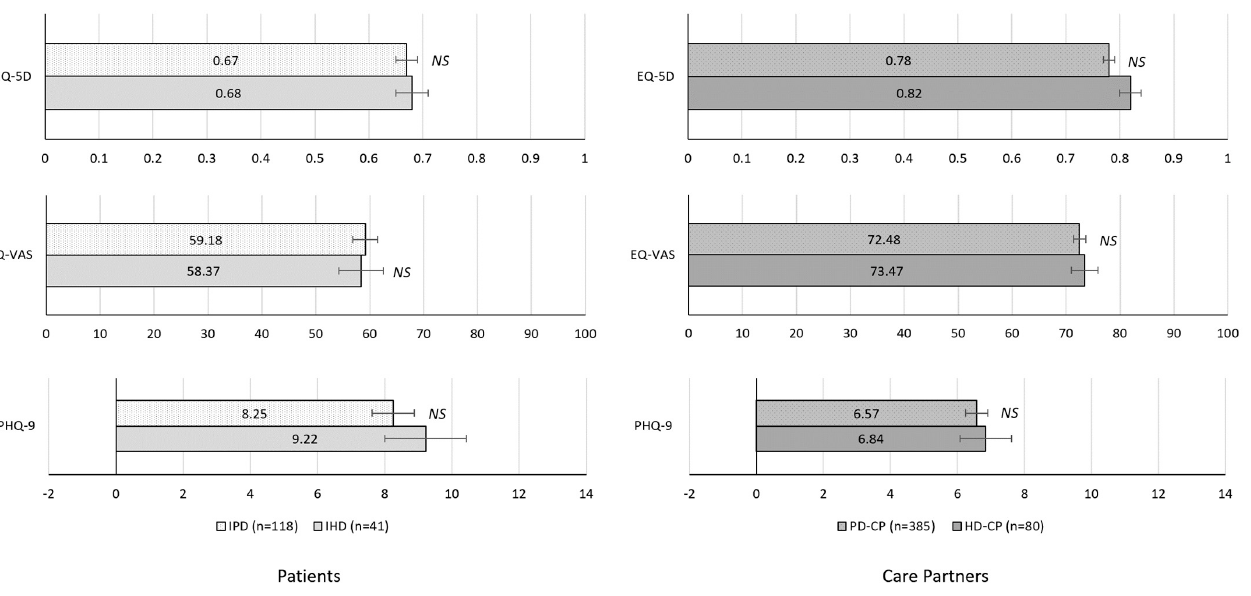
Figure 3. HRQoL outcomes of HD relative to GP. All comparisons adjusted for age and sex using propensity-score matching. Error bars indicate standard deviation. * p < 0.001. GP, general population; IHD, individuals with Huntington’s disease; CP, care partner; HRQoL, health-related quality of life.